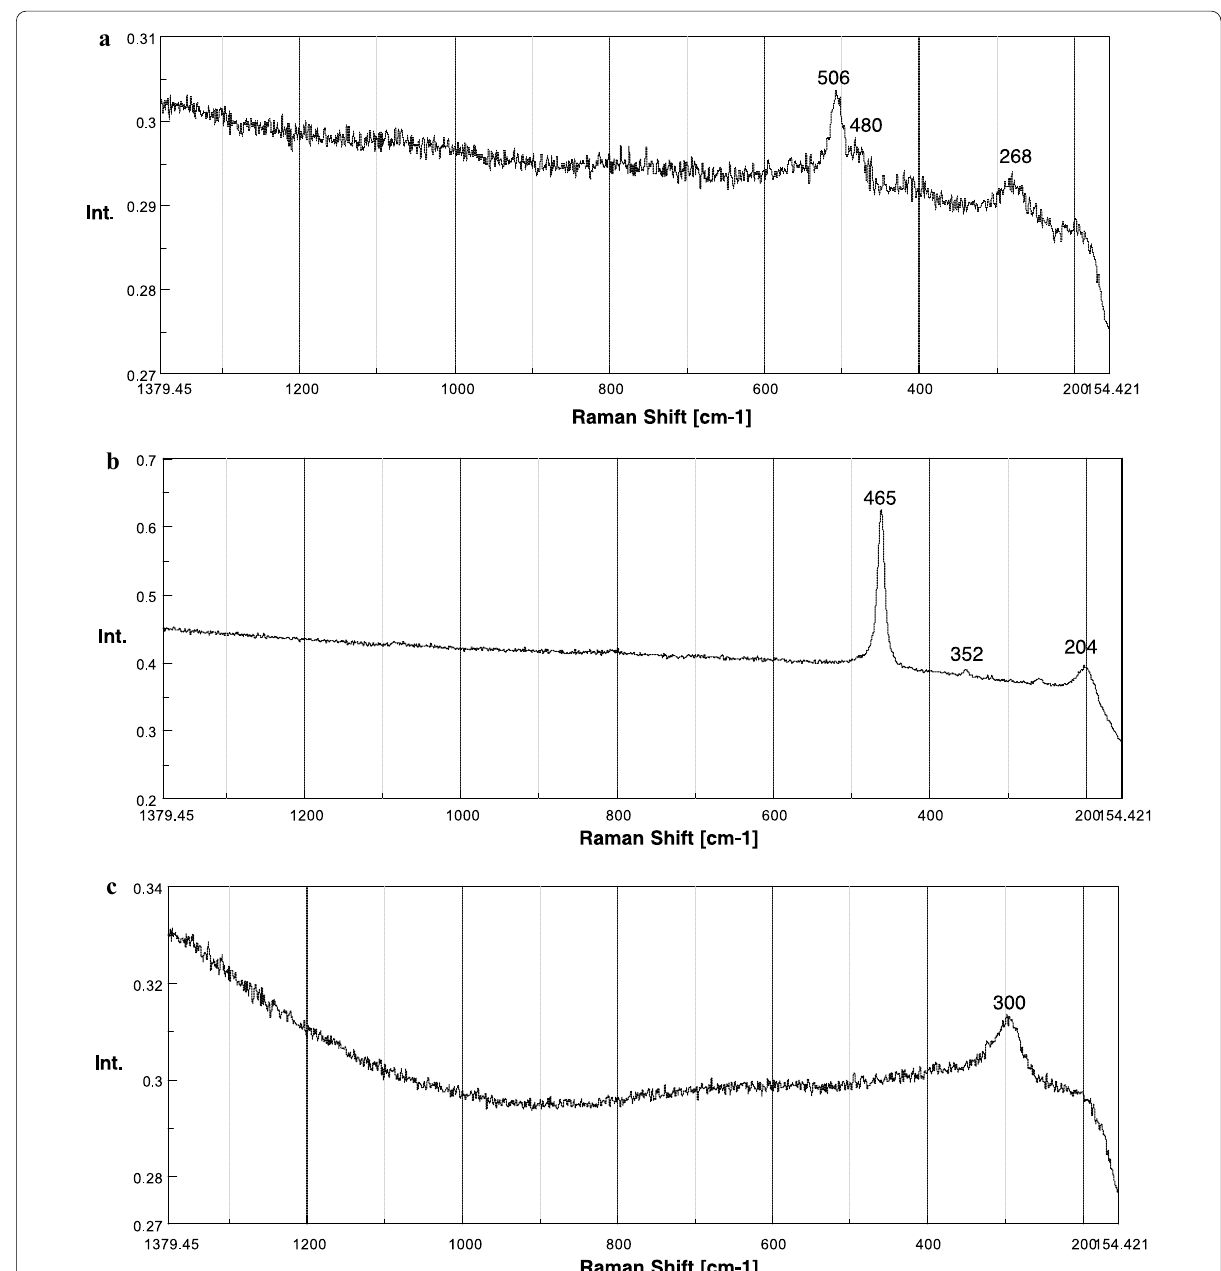
Fig. 7 Raman spectra of a plagioclase in a chondrule, b quartz in a chondrule, and c buseckite in a chondrule. All are from chondrules in